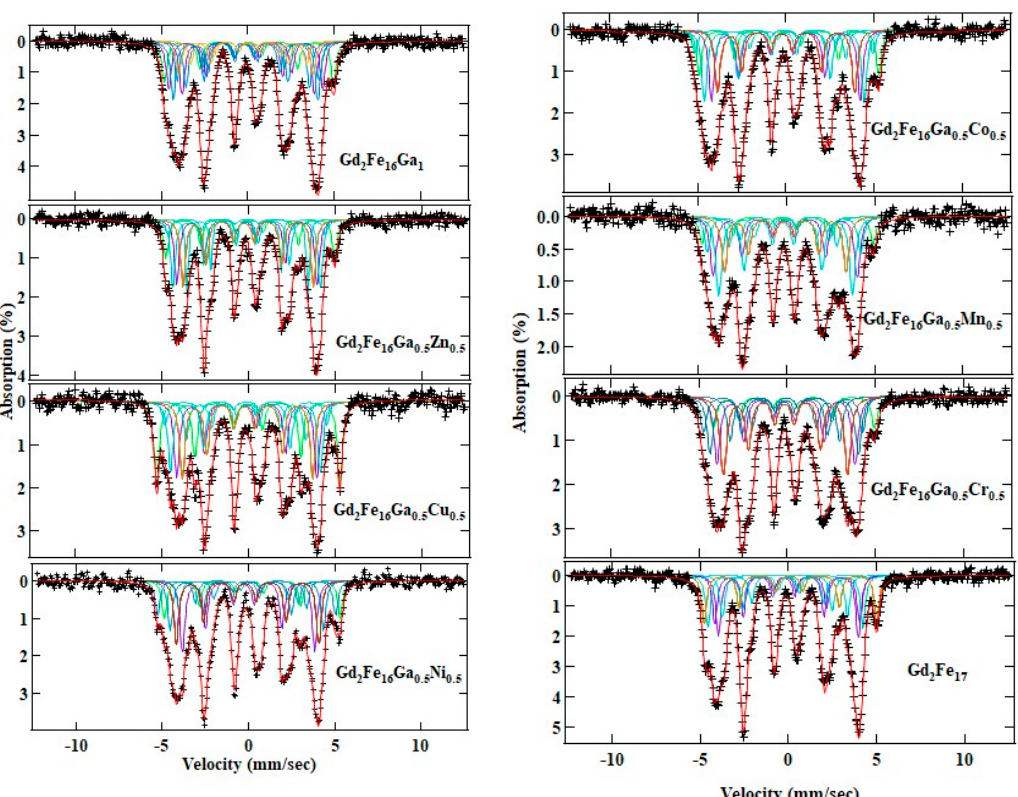
Figure 6. Fitted RT Mössbauer spectra of Gd 2 Fe 17 and Gd 2 Fe 16 Ga 0.5 TM 0.5 (TM = Cr, Mn, Co, Ni, Cu, Zn, and Ga).